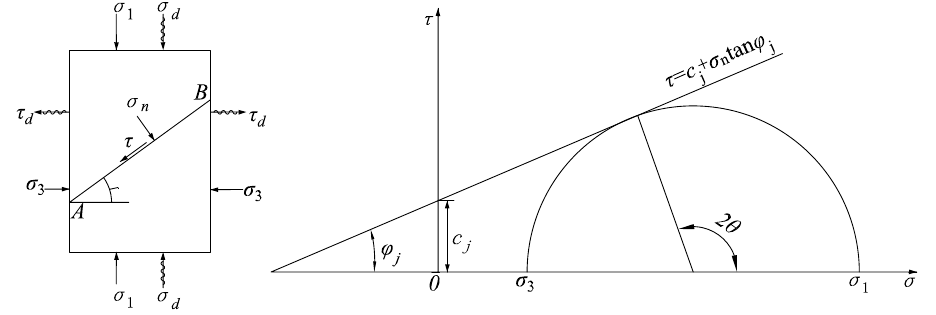
Figure 1. Stress state of a structural plane in rock under dynamic disturbance.